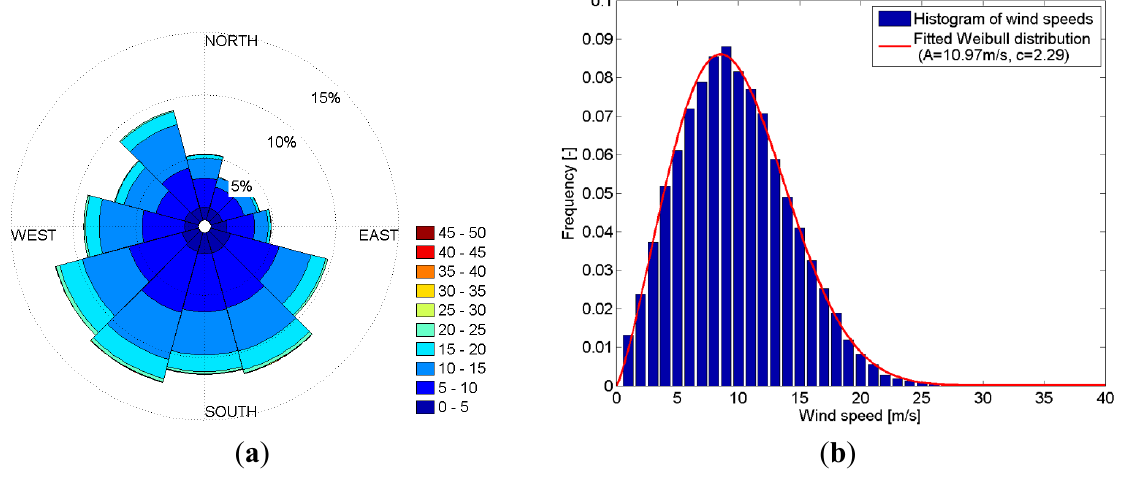
( a ) ( b ) Figure 4. Characteristics of the 3 years’ wind data at hub height: ( a ) wind rose; ( b ) Weibull distribution.